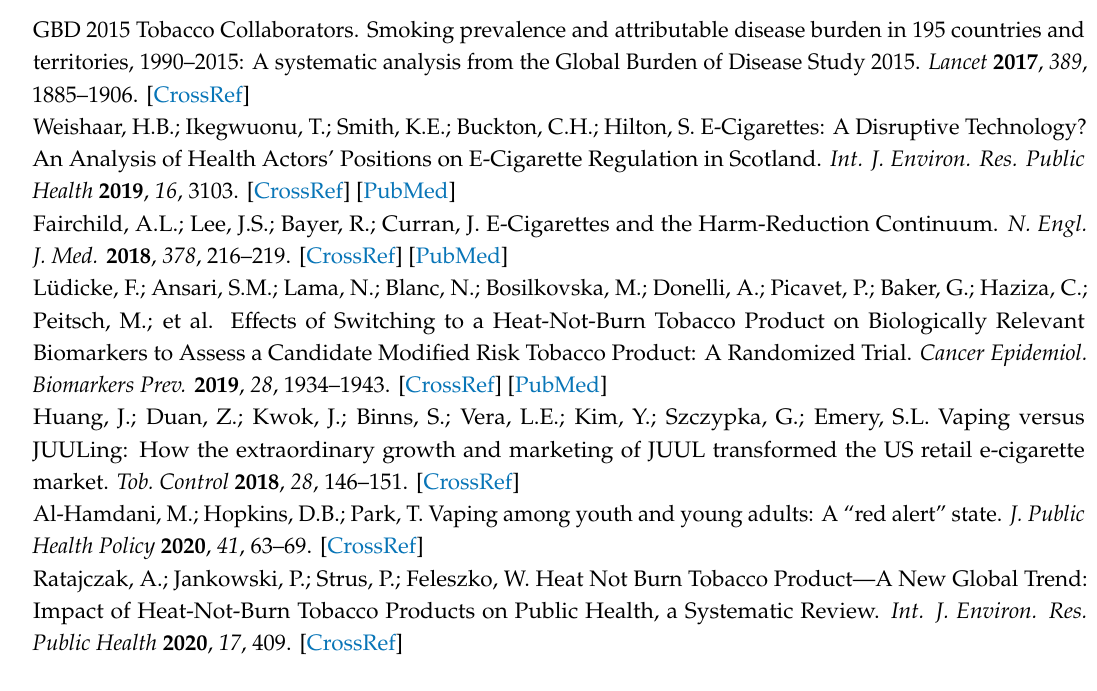
Figure S1. Example of measurements obtained during a single-modified risk product subtype smoking session by an individual smoker, totalling 262 values. Left panel highlights measurements before smoking, middle panel measurements during smoking, and right panel measurements after smoking, for a total time of 13 min. In the present case, a Glo Aegean was used. PM 10 = PM with diameter ≤ 10 µ m; PM 4 = PM with diameter ≤ 4 µ m; PM 2.5 = PM with diameter ≤ 2.5 µ m; PM 1 = PM with diameter ≤ 1 µ m., Table S1. Levels of particulate matter (PM), expressed as µ g / m3, comparing di ff erent